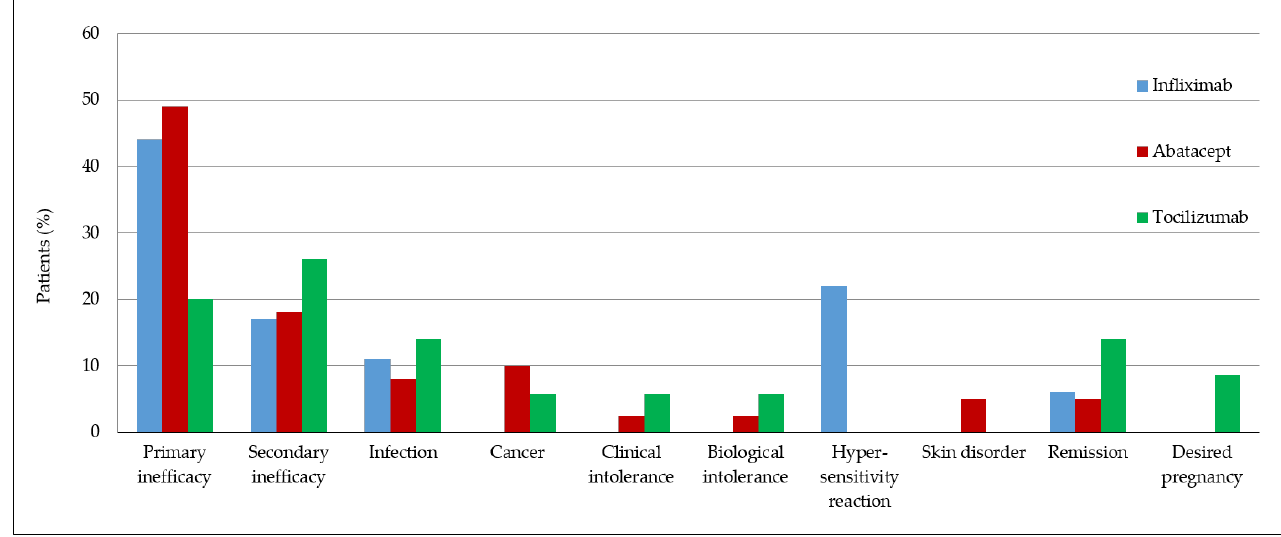
Figure 5. Reasons for bDMARD discontinuation.